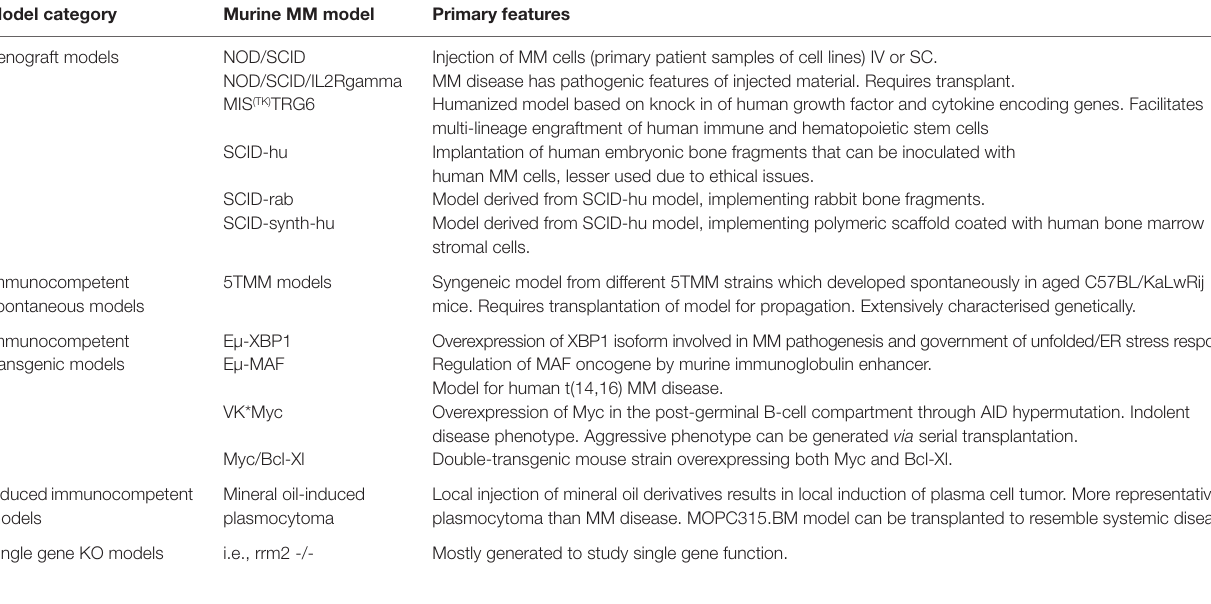
TABLE 1 | Schematic overview of murine models available for studying MM disease biology. Models are categorized according to genetic build. Model